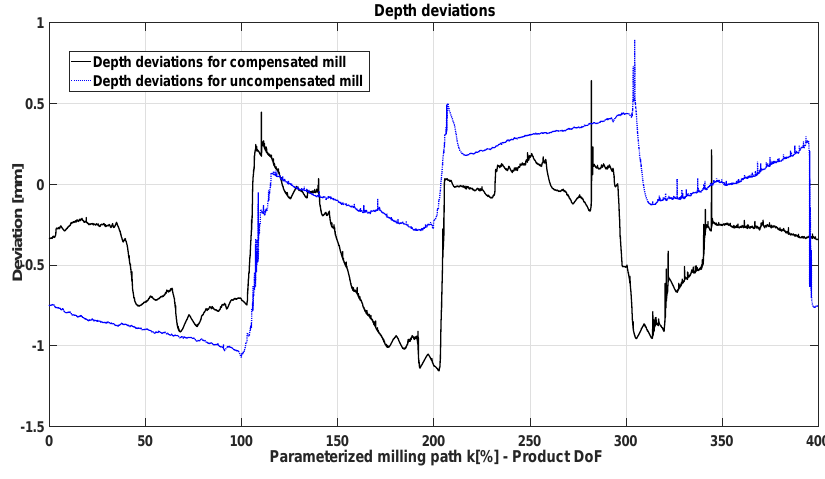
Figure 17. Depth deviations for compensated and uncompensated